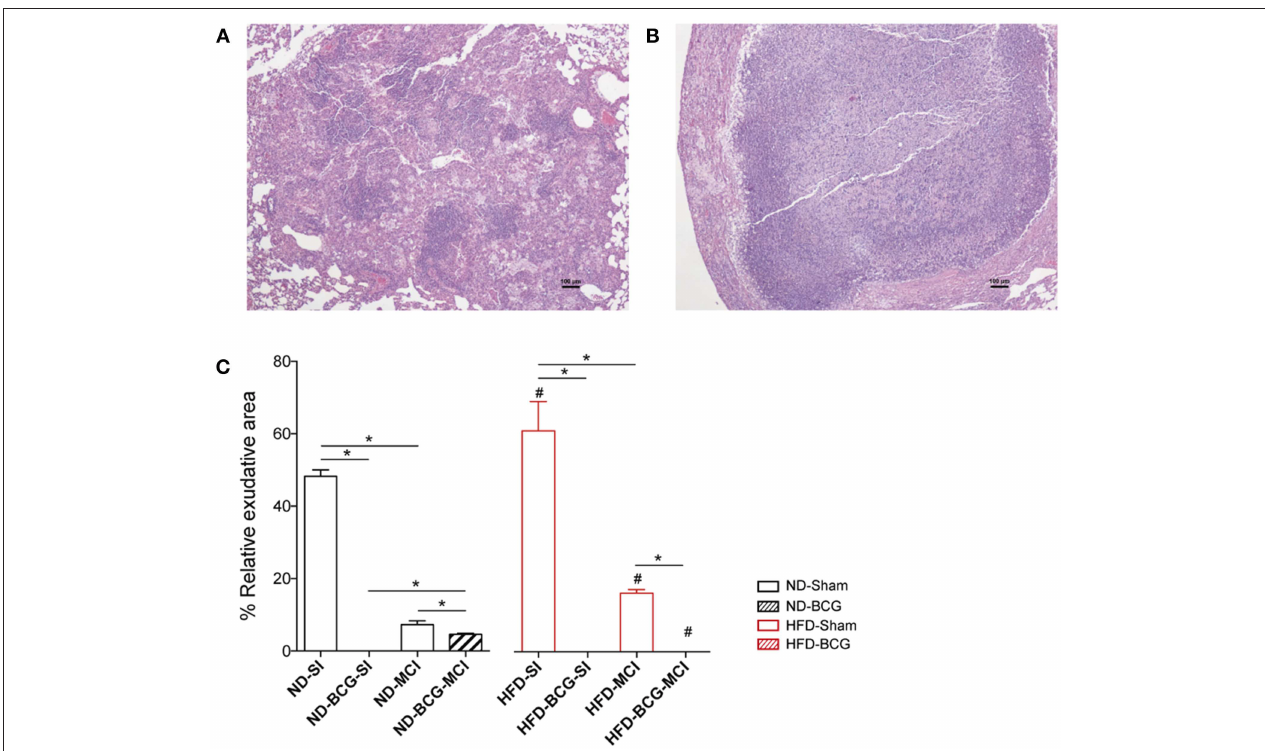
FIGURE 4 | Quality of the lesions found at week 16 post-infection. The tissue sections show a proliferative (A) and an exudative (B) lesion stained with H/E. (C) Relative percentage of exudative lesions at week 16. Black bars represent ND groups while red bars represent HFD groups. Hatched bars in each type of diet represent vaccination Bar plots show median with range. Asterisk indicates differences between vaccination and infection in each diet; hashtag indicates differences between diets. * p < 0.05, # p < 0.05; Mann–Whitney test.